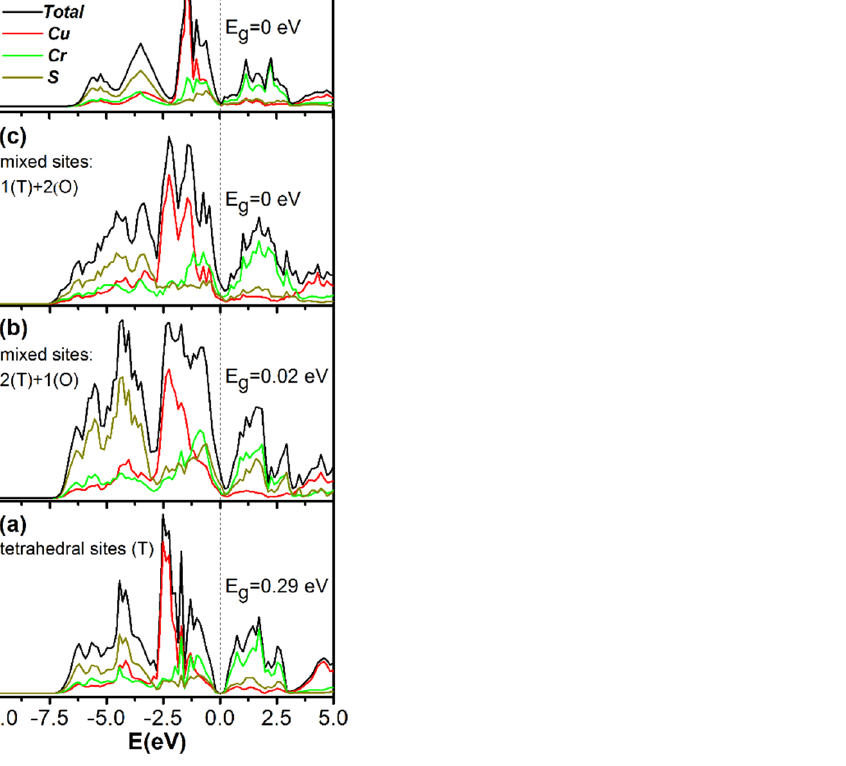
Figure 5. Simulated DOS of CuCrS 2 : copper atoms localized at tetrahedral ( a ), octahedral ( d ) and mixed both tetrahedral and octahedral sites ( b , c ).